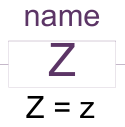
Figure 12. Toolkit icon for a series impedance